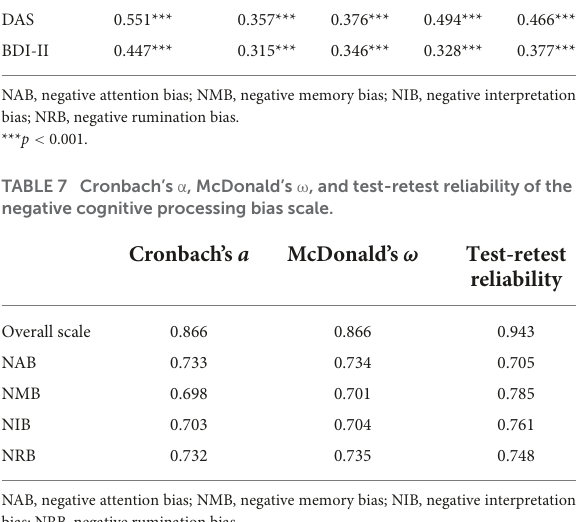
TABLE 6 Pearson’s correlations between the negative cognitive processing bias scale and the criterion measures. Overall scale NAB NMB NIB NRB